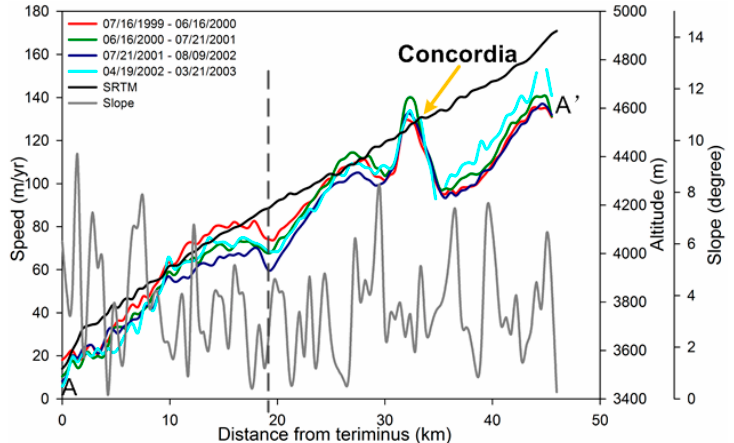
Figure 4. Annual speed profiles along the centerline (AA’) of the Baltoro Glacier. The centerline location is indicated by the dashed line in Figure 3a. The gray dashed line marks the end-point location of the centerline profile for average velocity estimation in Table 2.